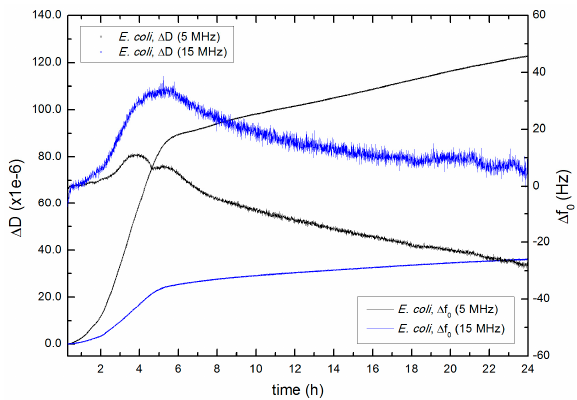
Figure 9. Evolution of ∆ D and ∆ f 0 (5 MHz and 15 MHz) for E. coli TRGM (MG1655) biofilm formation. Measurement made in CFA at 30 °C.